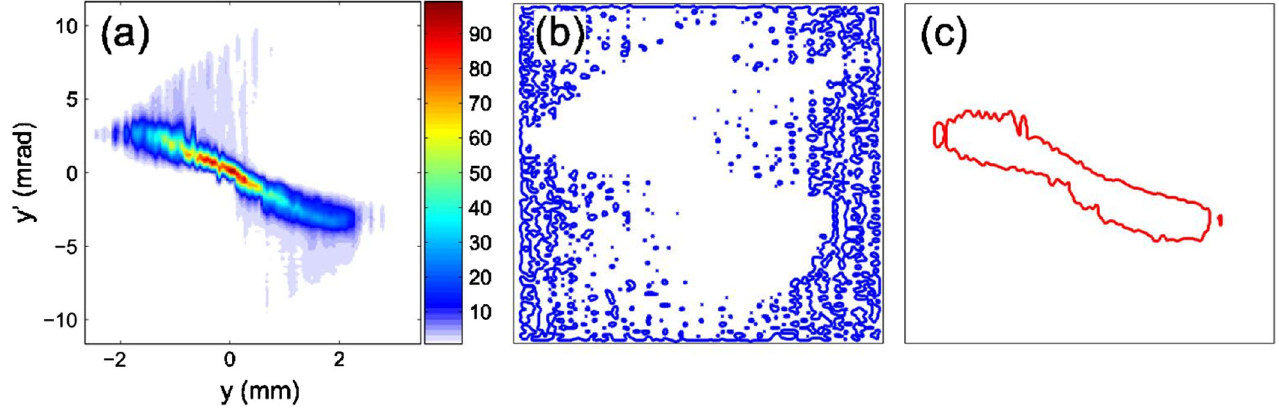
FIG. 11. (Color) Example of measured transverse phase space (a), with a contour map of a binary image after applying 0.6% (b) and 4.4% (c) threshold of the peak intensity.